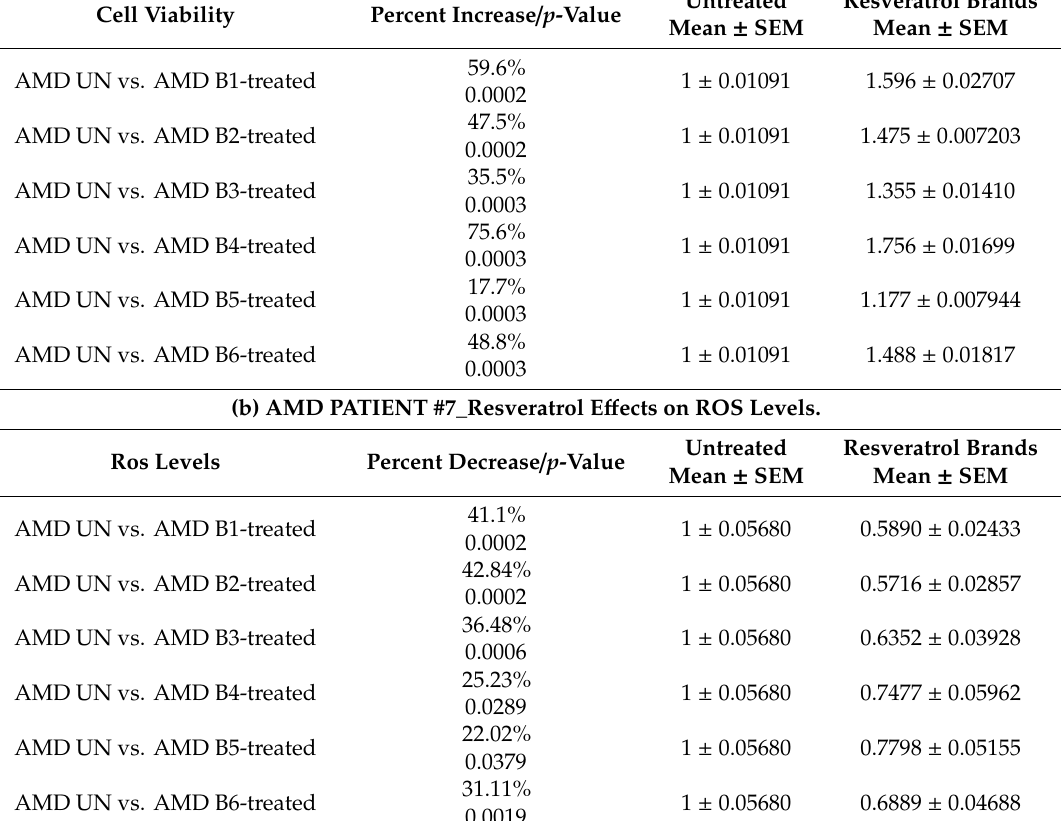
Table 9. E ff ects of resveratrol formulations on cell viability ( a ) and ROS levels ( b ) in AMD patient # 7. (a) AMD PATIENT #7_Resveratrol E ff ects on Cell